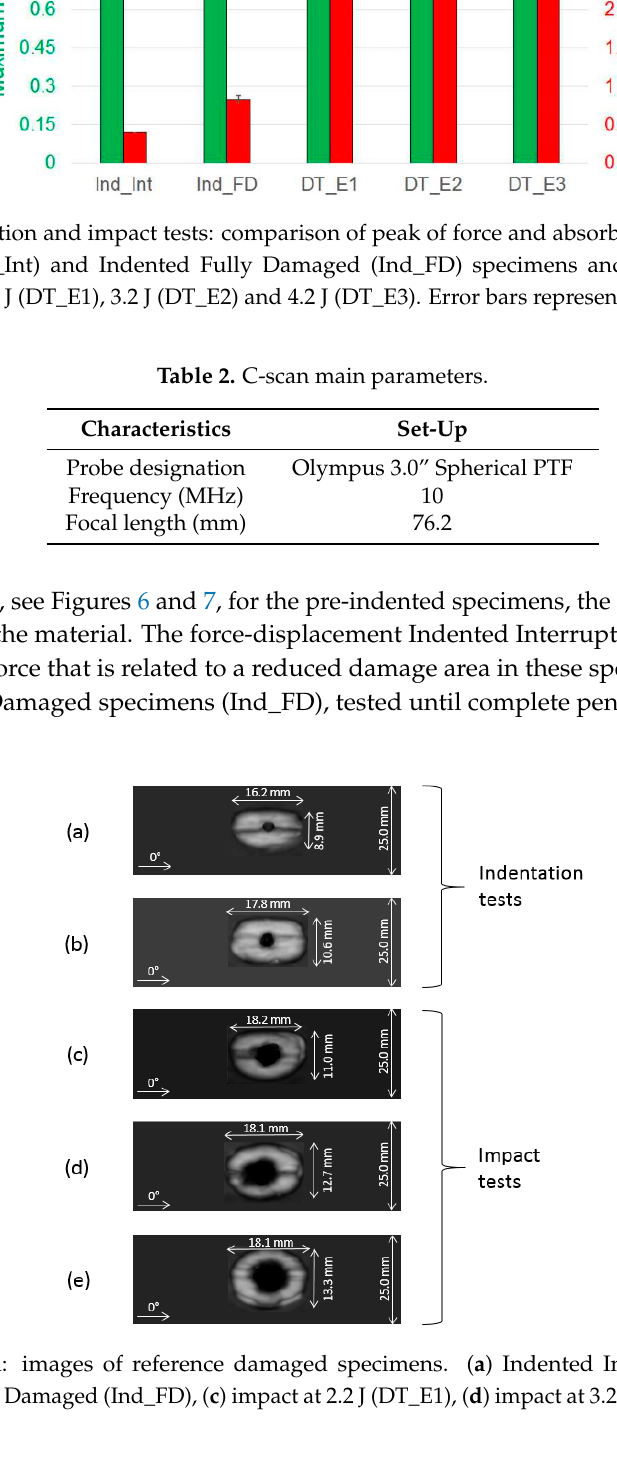
Table 2. C-scan main parameters.